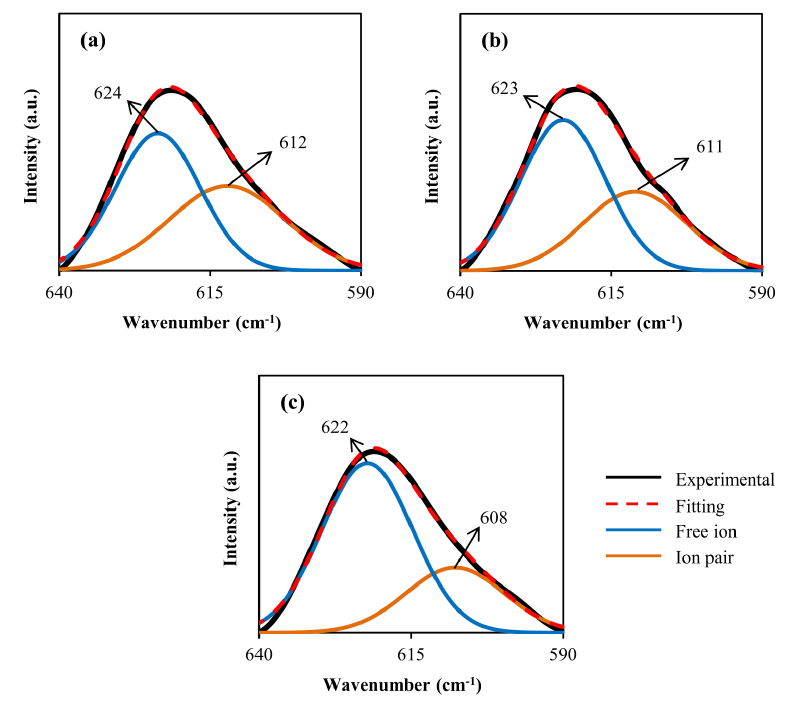
Figure 4. Deconvolution of FTIR spectra at a wave number between 590 and 640 cm − 1 for ( a ) CDLG–1, ( b ) CDLG–2, and (c) CDLG–3 plasticized electrolyte